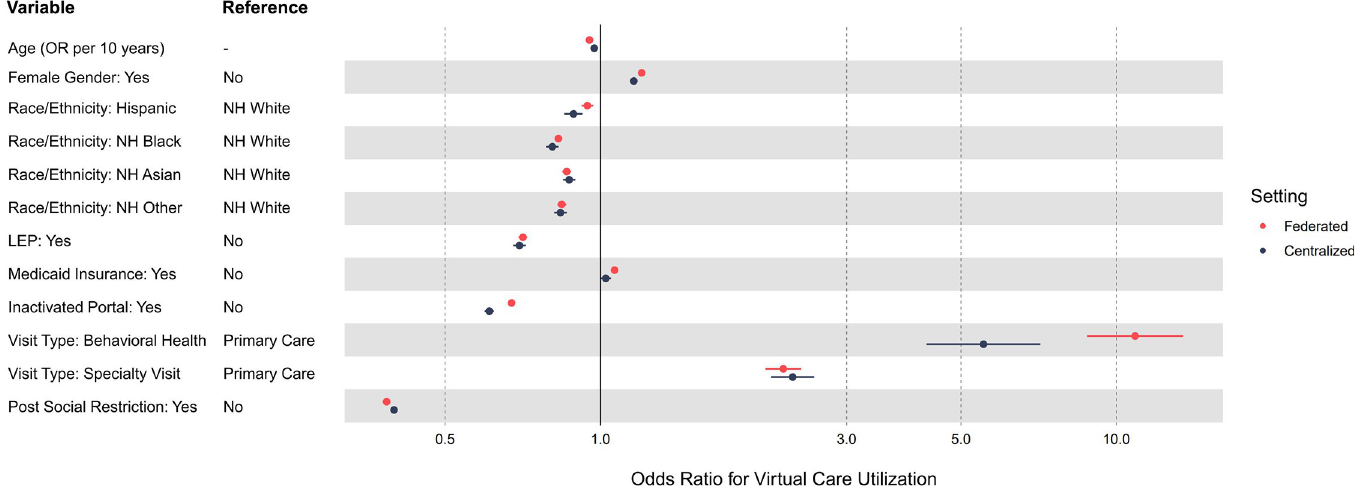
Fig 4. Adjusted odds ratios of virtual vs. in-person visit by patient and visit characteristics. Using the forest plot, we visualized the adjusted odds ratios obtained through Fed-GMM for both all facilities (federated setting to demonstrate privacy preservation) and single facility (centralized setting to demonstrate computation improvement). The points and bars represent the point estimates and 95% confidence intervals, respectively. Abbreviations: OR—Odds Ratio; NH—Non-Hispanic; LEP— Limited English Proficiency.